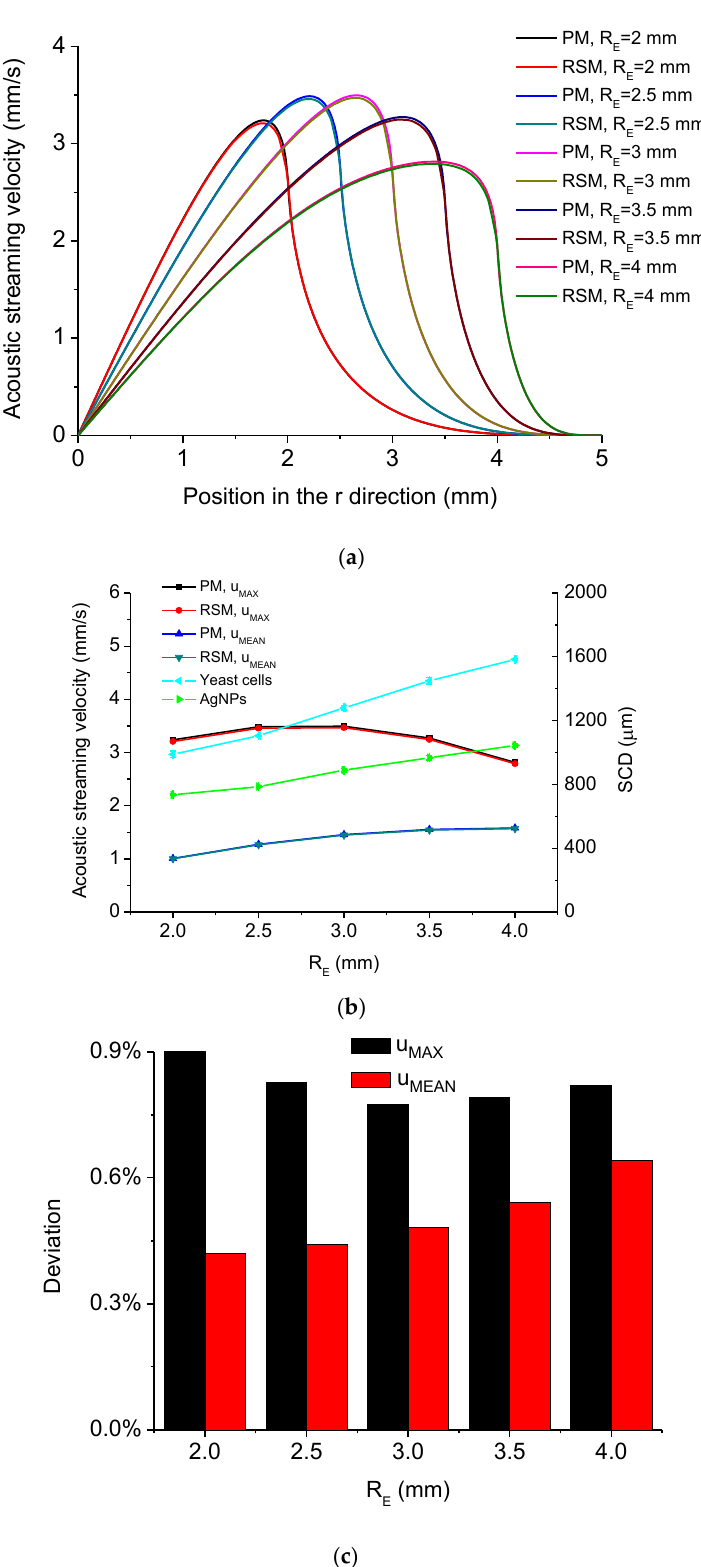
Figure 13. ( a ) Computed acoustic streaming velocity magnitude distribution along the r direction at the droplet-substrate interface in the droplet-ultrasonic substrate system under different R E . ( b ) u MAX , u MEAN and SCD versus R E in the droplet-ultrasonic substrate system. ( c ) Deviations of u MAX and u MEAN computed by the PM and RSM versus R E in the droplet-ultrasonic substrate system.